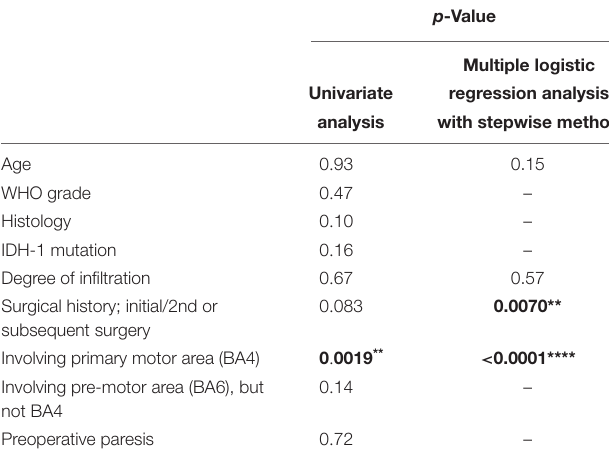
TABLE 3 | Related factors of motor functional shift in patients with frontal